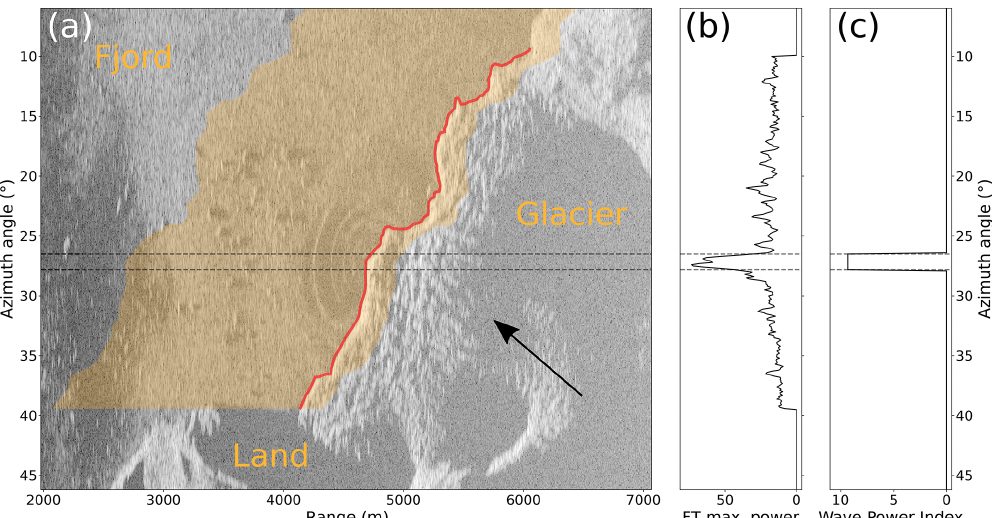
Figure 2. Example of calving wave detection. (a) Radar image of 7 July 2018 at 06:21:00UTC represented as the logarithm of the signal strength, visualized using the matplotlib Python library (Hunter, 2007). The black arrow indicates the ice flow direction, and the red line shows the outline of the glacier front. The translucent orange area shows the region of interest (ROI). (b) Maximum power of the Fourier transform by azimuth line obtained after the spectral analysis (step 3). (c) Wave power index (WPI) computed by TeRACWA (step 6). The two dashed lines indicate the boundaries of the wave detection in panels (a) and (b) . The part of the calving front in between the lines corresponds to the wave source area.